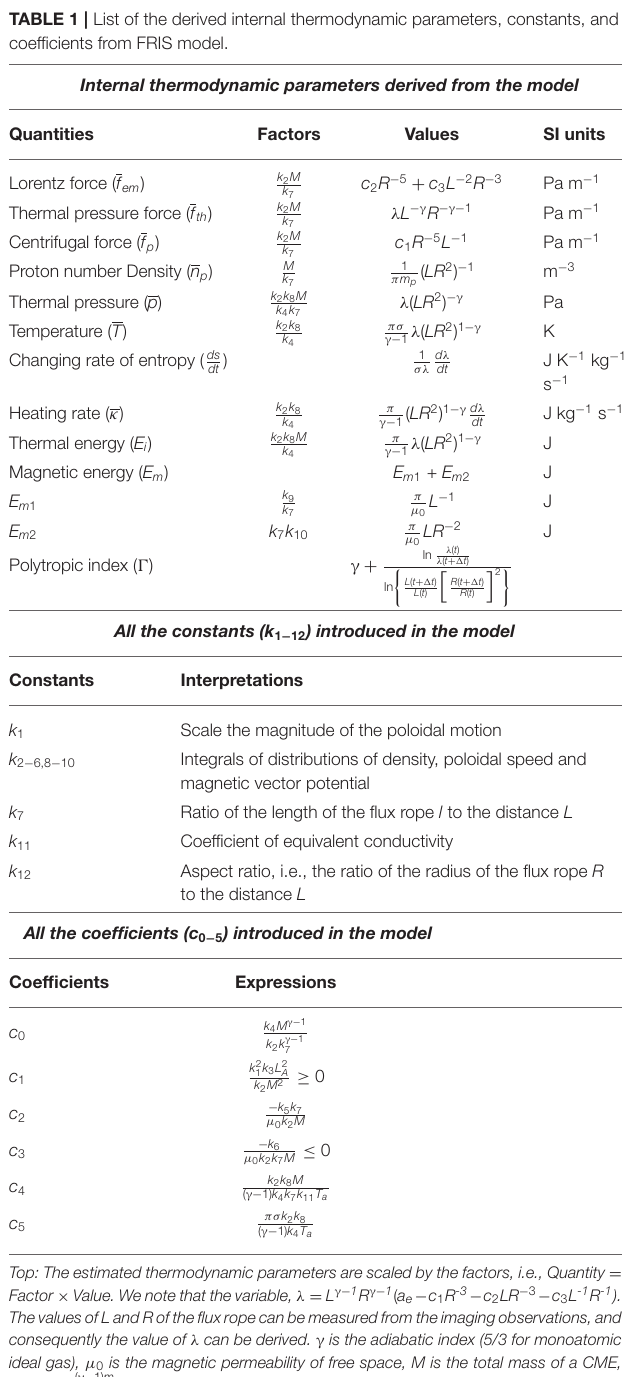
The relation between the unknown coefficients and the measurements of a CME flux rope is expressed in Equation